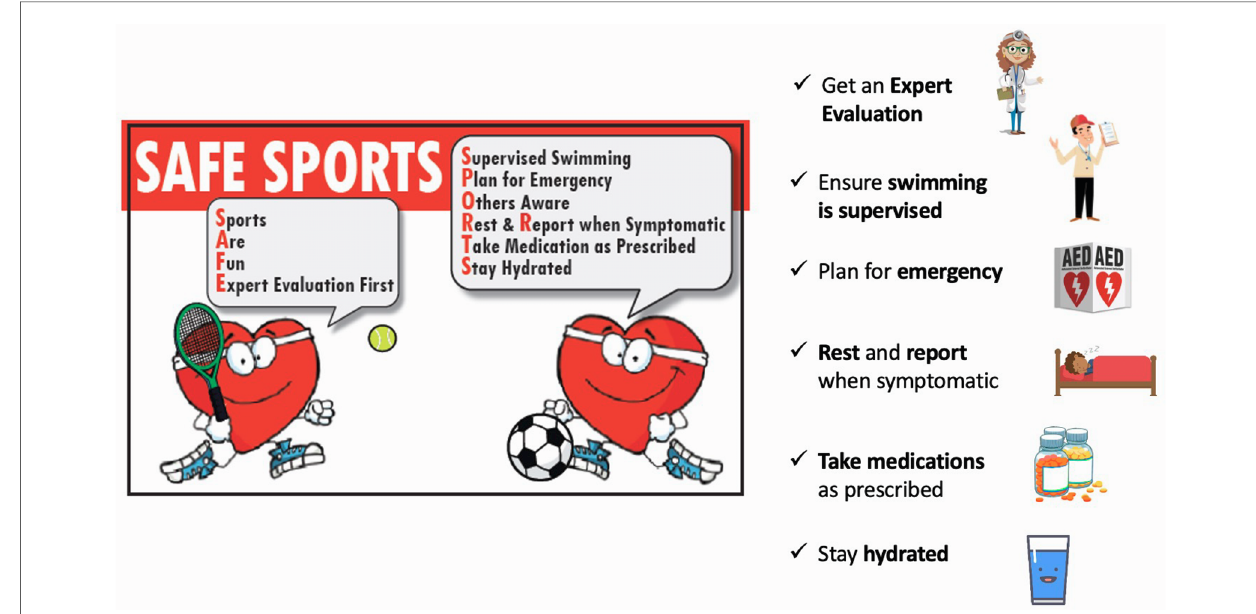
FIGURE 2 Safety of sports in children with inherited heart rhythm disorders. Modi fi ed from Cheung et al., 2016